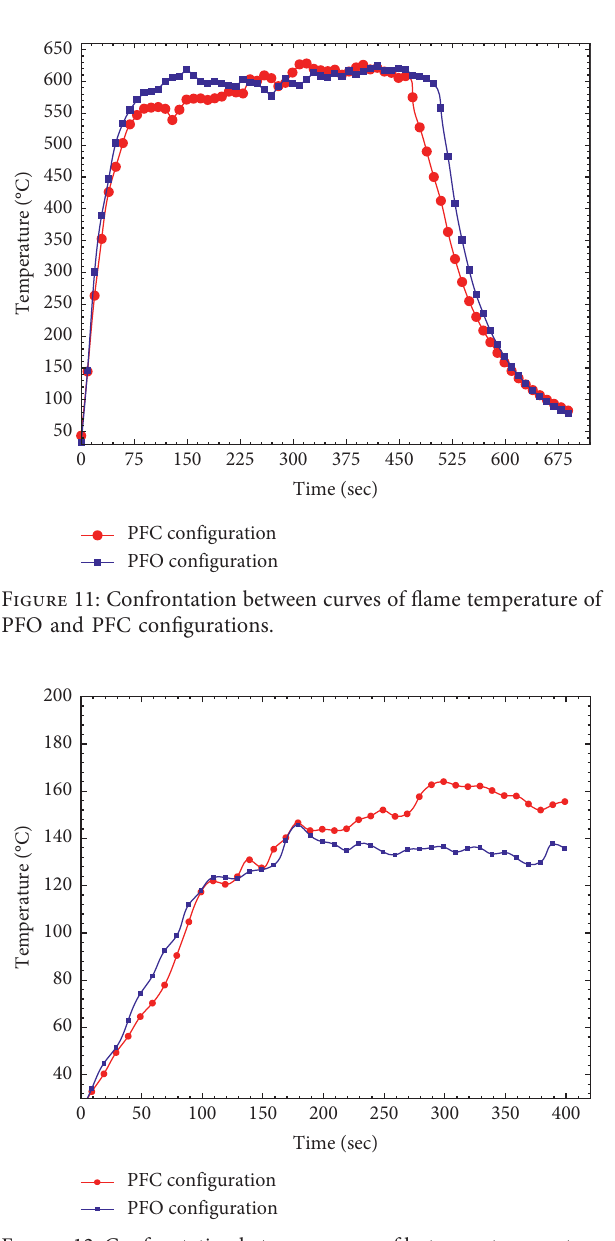
Figure 12: Confrontation between curves of hot gases temperature in the plume of PFO and PFC configurations.